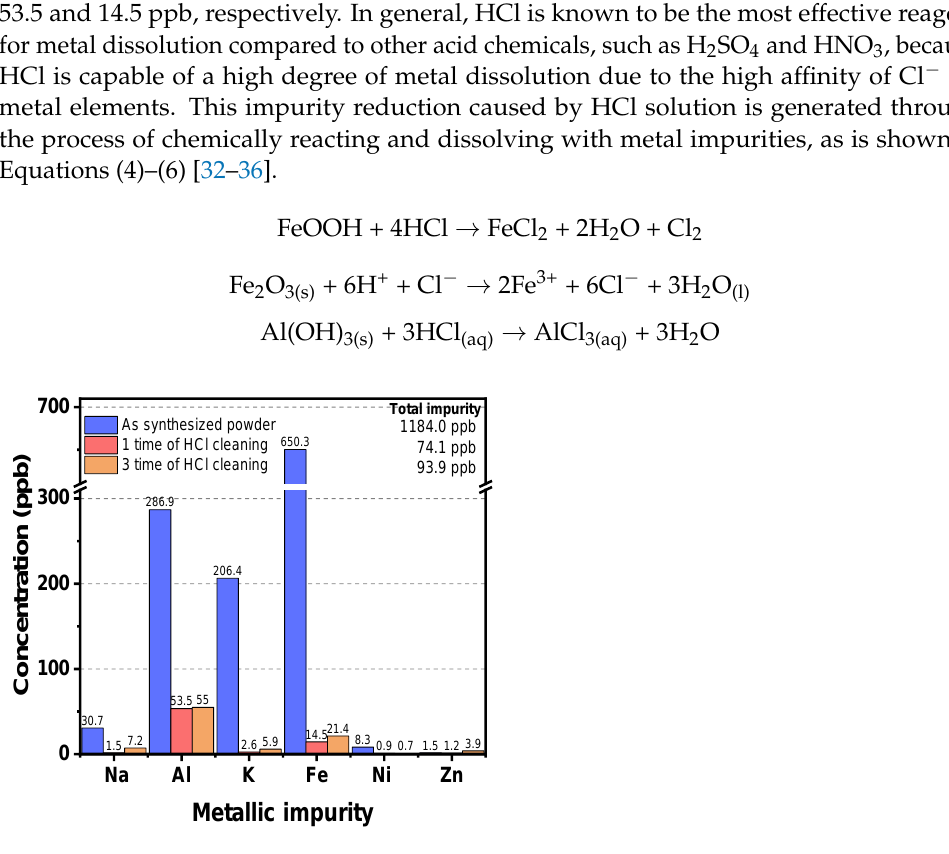
Figure 7. Effect of the HCl cleaning process on reduction of the metal impurity concentration of as-synthesized powder.